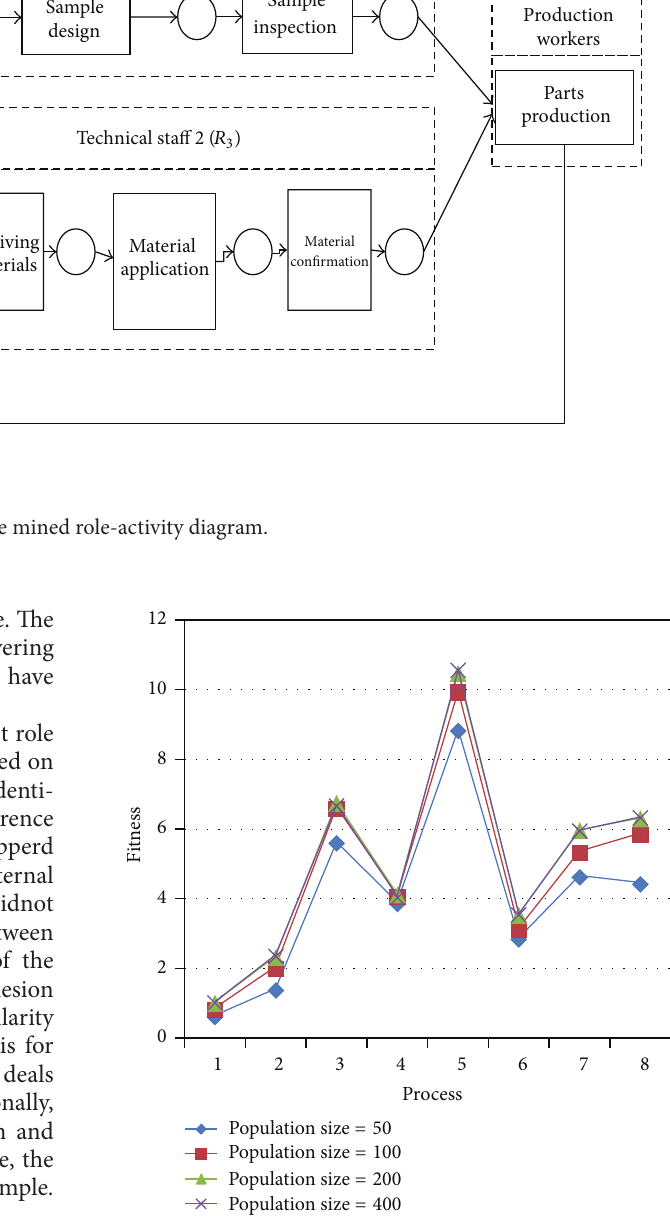
Figure 2: Comparison of different population